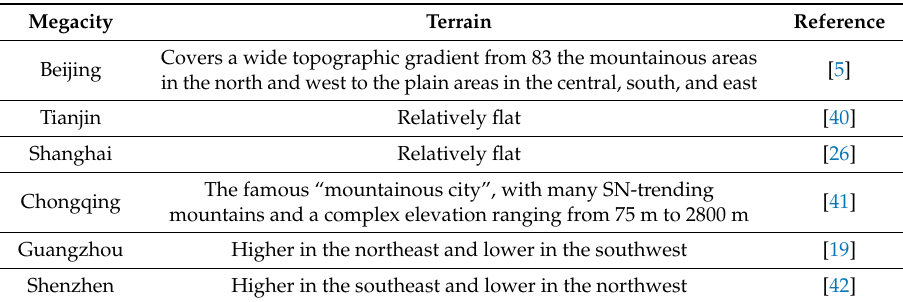
Table 3. Basic information of China’s six